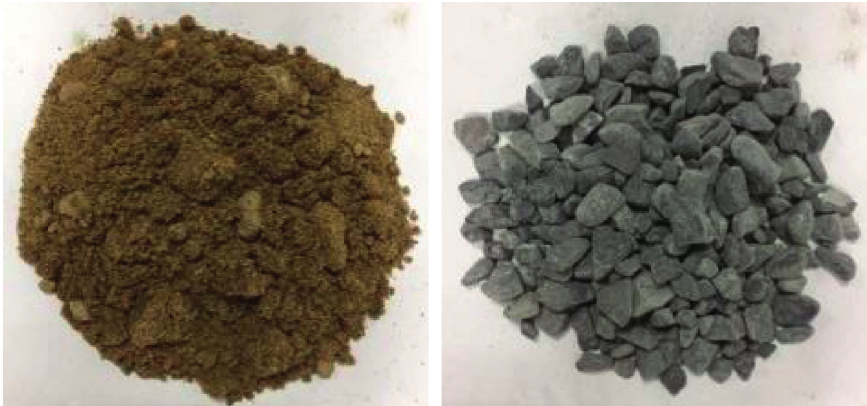
Figure 3: Similar material particle.